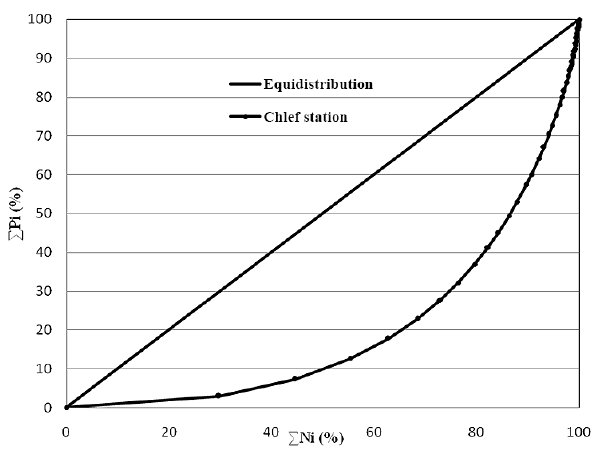
Figure 2. Concentration curve of Chlef meteorological station (1970–2008).